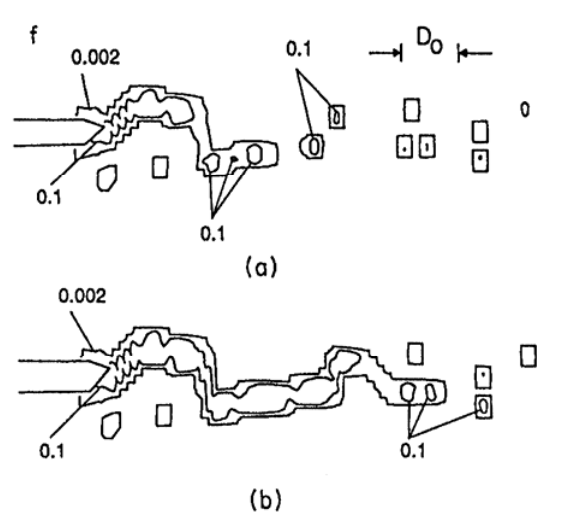
Figure 1: Crack growth indicated by contours of constant void volume fraction, f , for random distribution of larger